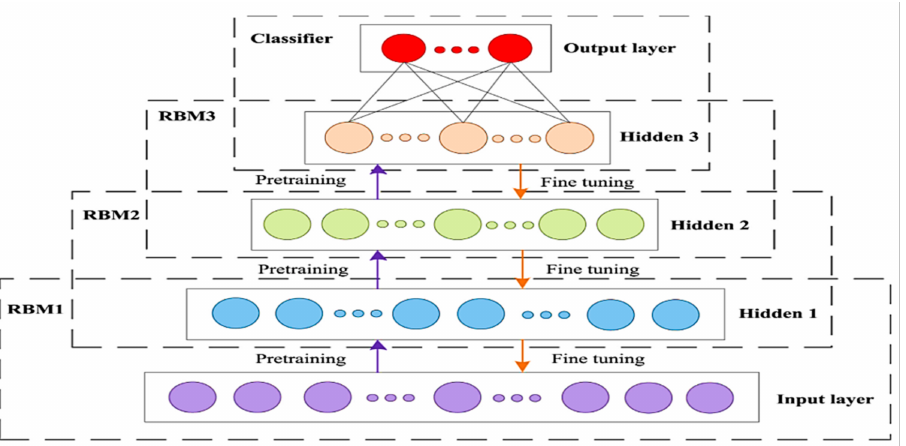
Figure 3. The configuration of the DBN consists of three mains stacked RBMs with an output layer. Copyright © 2021 Elsevier